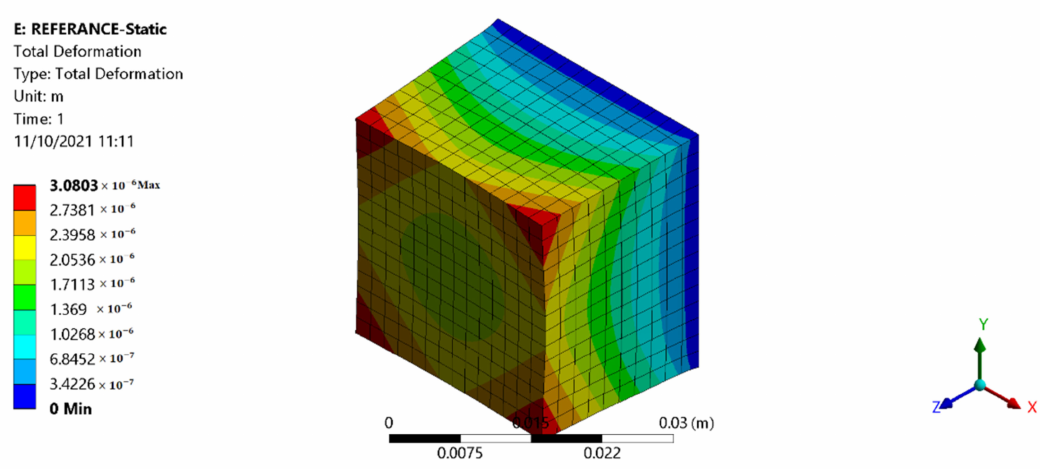
Figure 11. The result of the static analysis of a pair of two PIN24%-PMN-PT plates using Method 1 for reference purpose. Contact Between Plates.